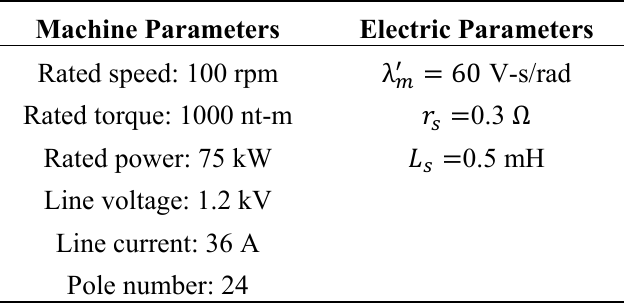
Table A1. Machine and Electric Parameters of